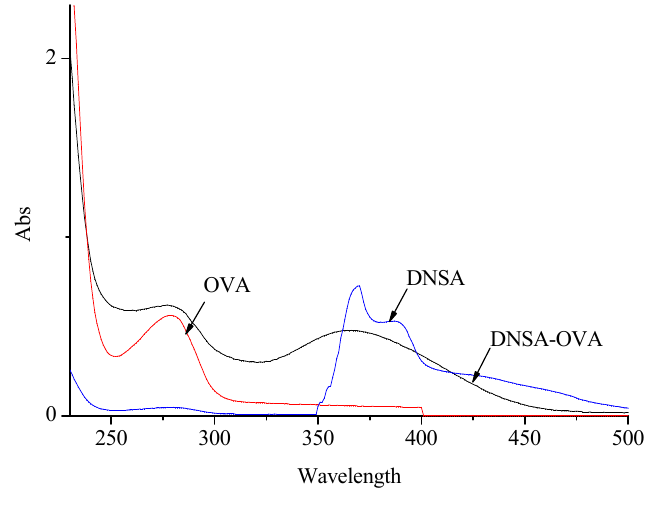
Figure 4. UV spectra of OVA, DNSA-OVA and